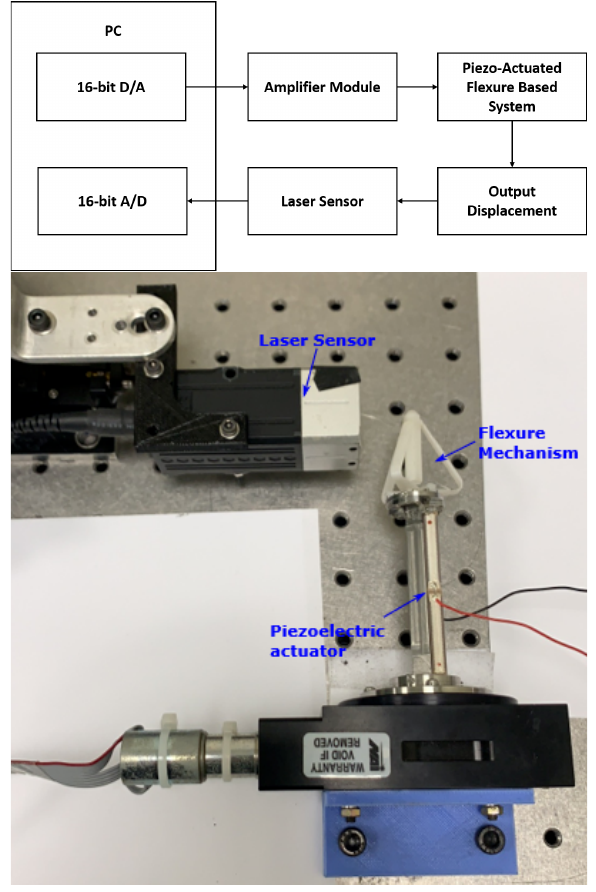
Figure 4. Experimental setup.